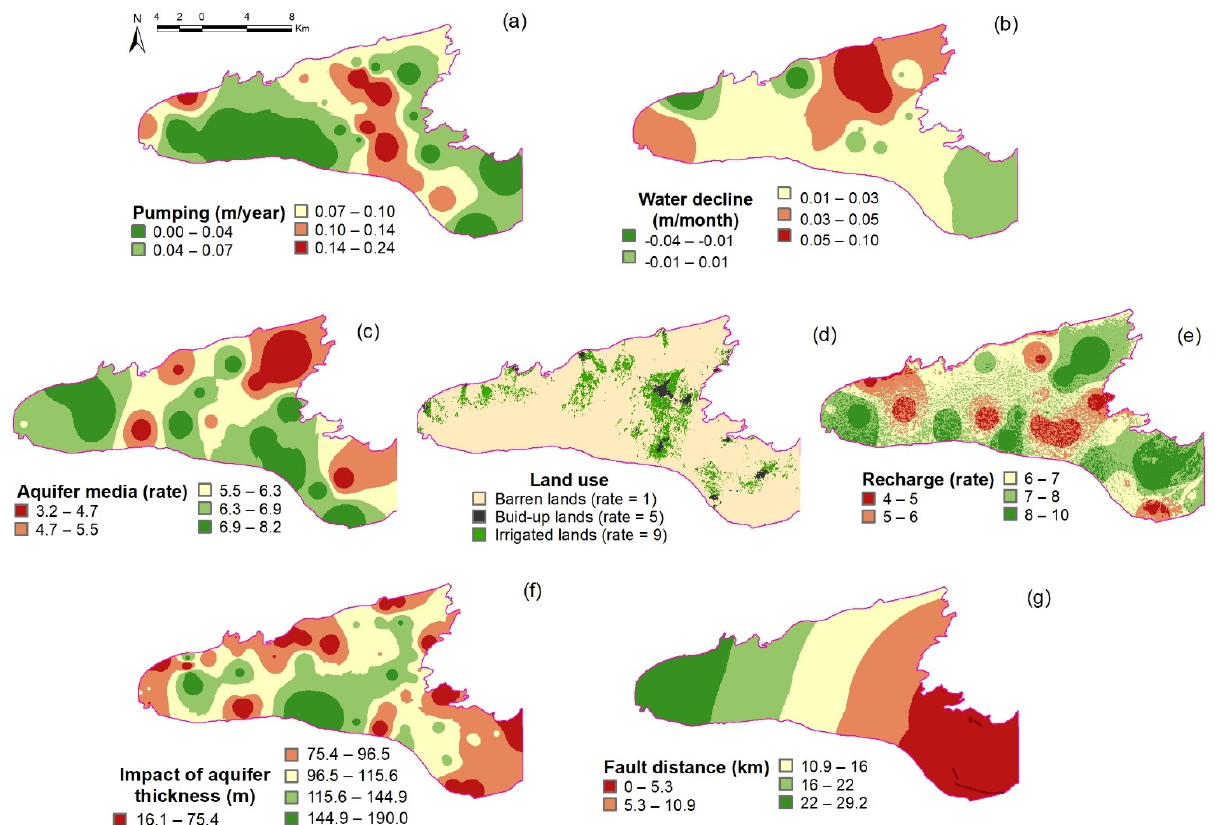
Figure 3. Hazard data layers: ( a ) pumping of groundwater; ( b ) water table decline; and vulnerability data layers: ( c ) aquifer media; ( d ) land use; ( e ) recharge; ( f ) impact of aquifer thickness; ( g ) fault distance.